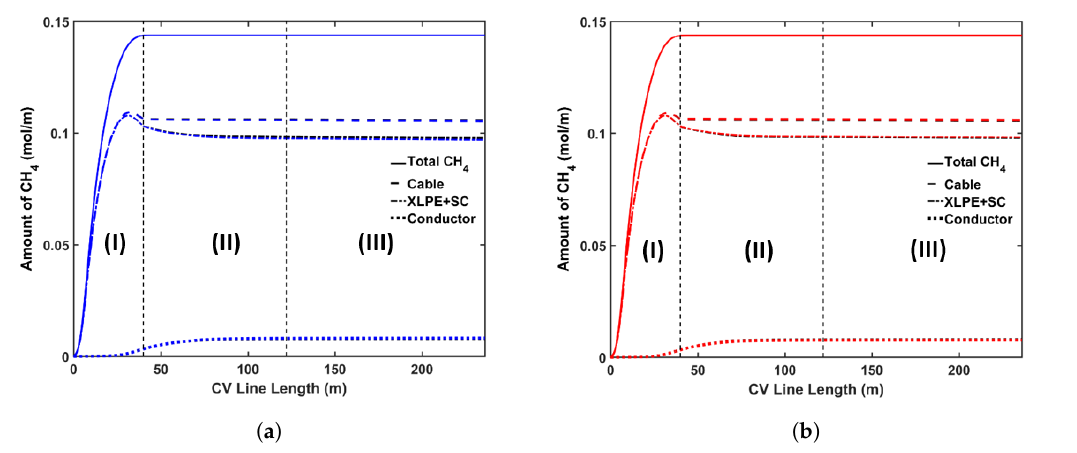
Figure 15. Axial CH 4 concentration profiles across CV line for cooling-water flow rate study. The black line represents the base case, the blue line in ( a ) represents Case 3a, and the red line in ( b ) represents Case 3b. Segments (I), (II) and (III) correspond to the curing tube and transition zone, water-cooling, and air-cooling segments,